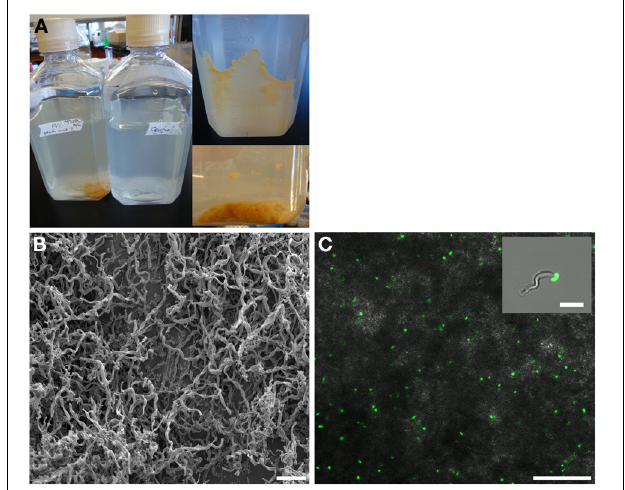
FIGURE 1 | (A) Left: large batch culture of M. ferrooxydans , strain PV-1 after 1 day of growth, compared to a control. Top-Right: formation of biofilm along the wall of culture bottle after 1 day of growth. Bottom-Right: the biofilm dislodges and forms fluffly flocculent material. (B) s.e.m. image of the mats of PV-1 (bar = 10 μ m). (C) Confocal fluorescent and bright field composite image of the mats of PV-1 (bar = 25 μ m). Inset: composite image of isolated PV-1 cell and stalk (bar = 4 μ